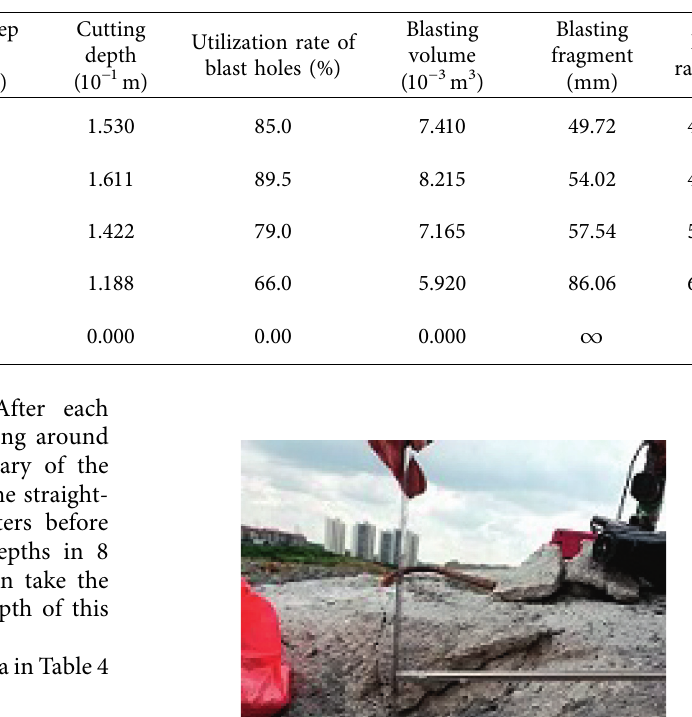
Table 4: Statistical table of relevant indexes of blasting experiment.